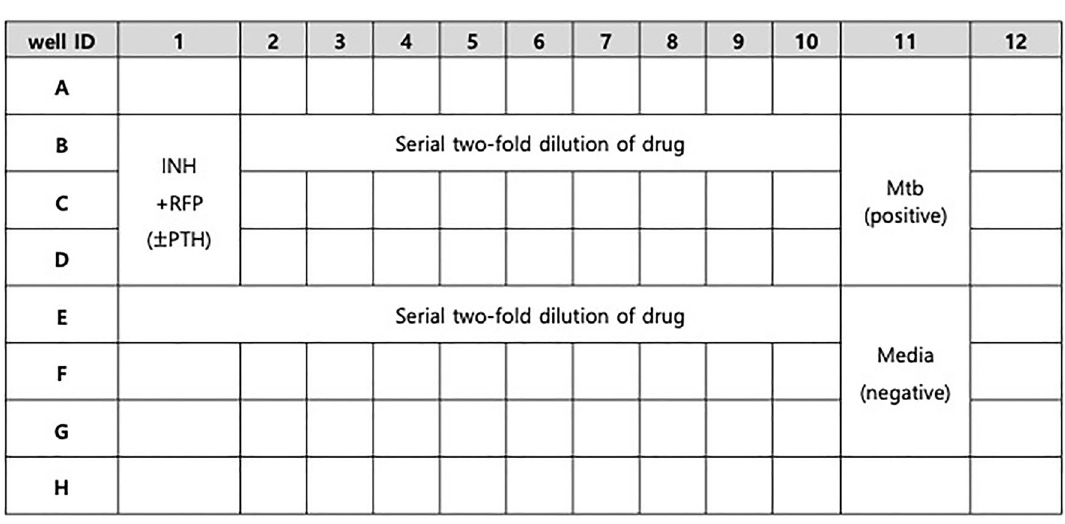
Figure 6. Image of 96-well plate (Corning ® 96 Well TC-Treated Microplates, Sigma-Aldrich, St. Louis, MO, USA) for resazurin minimum inhibitory concentration (MIC) assay method. Abbreviations: INH, isoniazid; Mtb, Mycobacterium tuberculosis ; PTH, teriparatide; RFP,